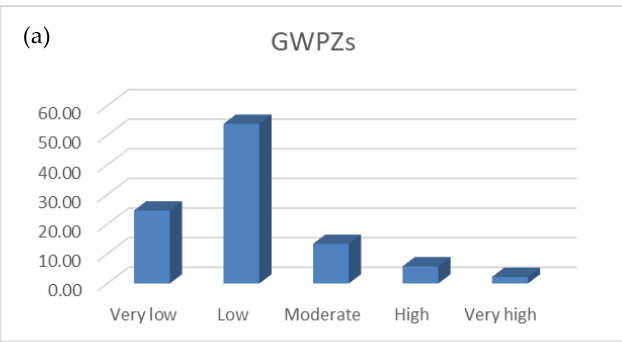
Figure 9. Cont (b)